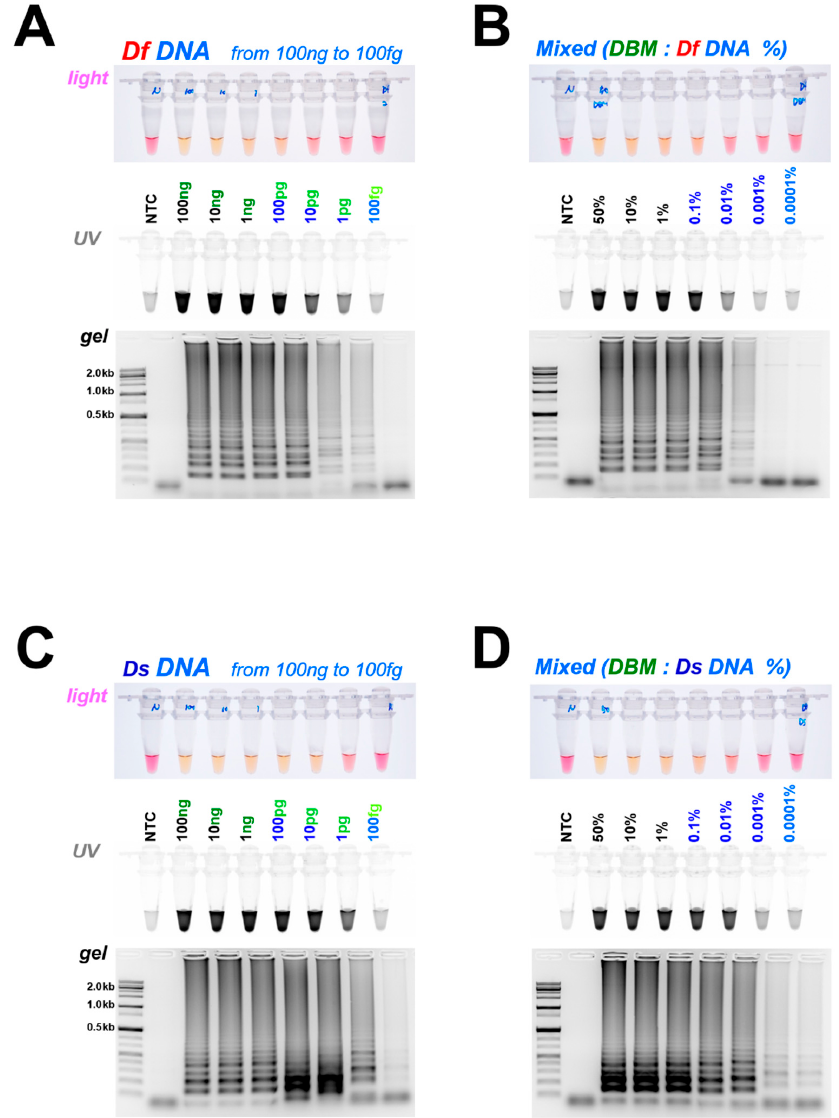
Figure 5. Identification of the detection limit of genomic DNA in the LAMP assay of ( A ) Df and ( C ) Ds from 100 ng to 100 fg under visible light, ultraviolet light with SYBR Green, and gel electrophoresis. LAMP assay with varying ratios (0.0001%–50%) of ( B ) Df and ( D ) Ds gDNA mixed with DBM gDNA to a total of 100 ng. All LAMP assay results were generated with incubation at 63 °C for 35 min, with five primers (F3, B3, FIP, BIP, and LB). The abbreviations are the same as described in